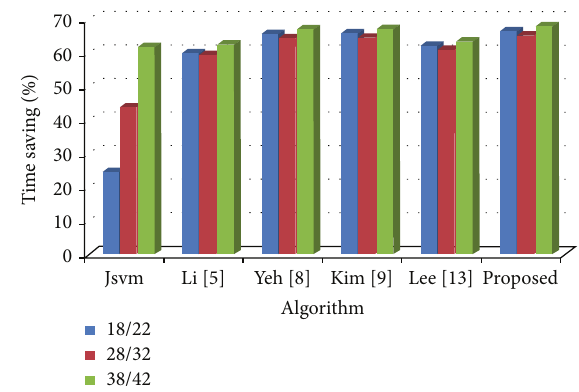
Figure 4: Time saving relationship among different algorithms for various values of